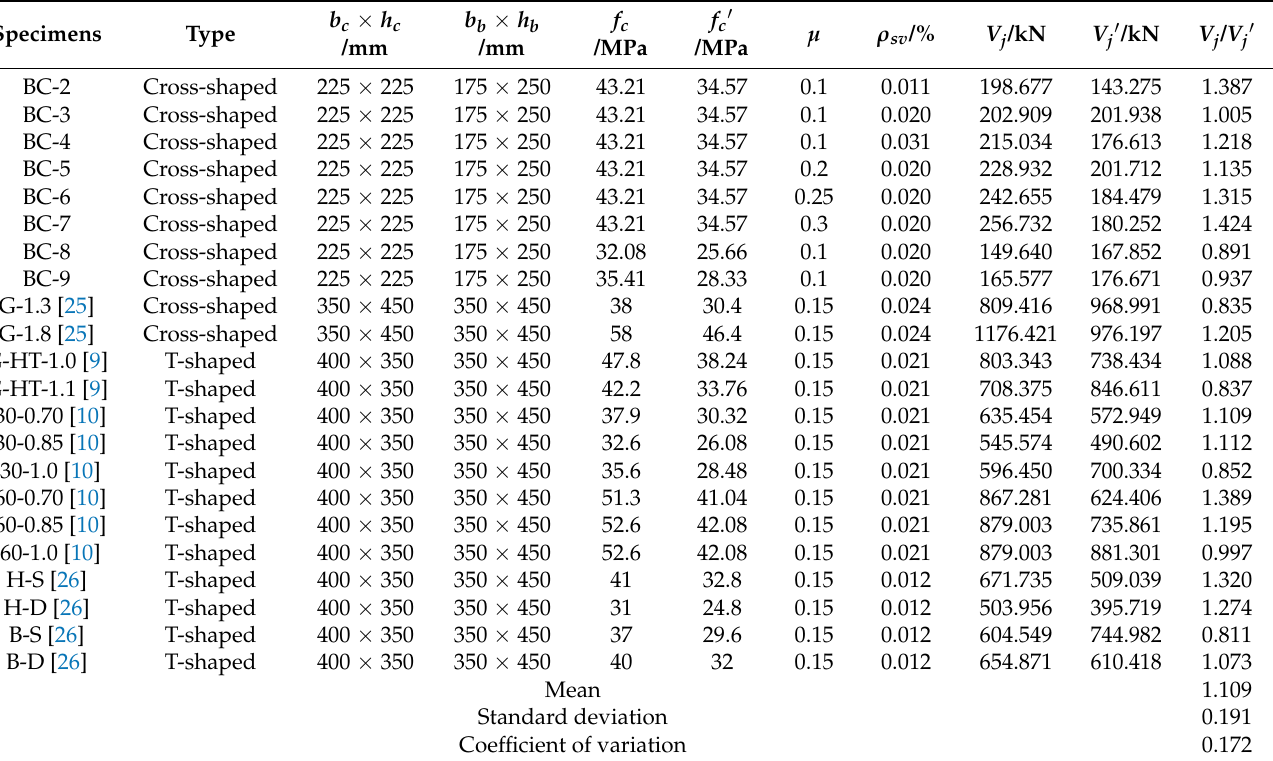
Table 7. Comparison of shear bearing capacity between theoretical and experimental